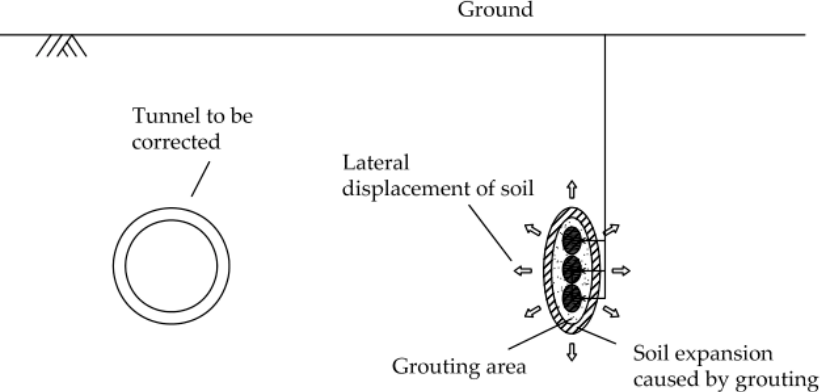
Figure 1. A schematic diagram of the corrective action of grouting.